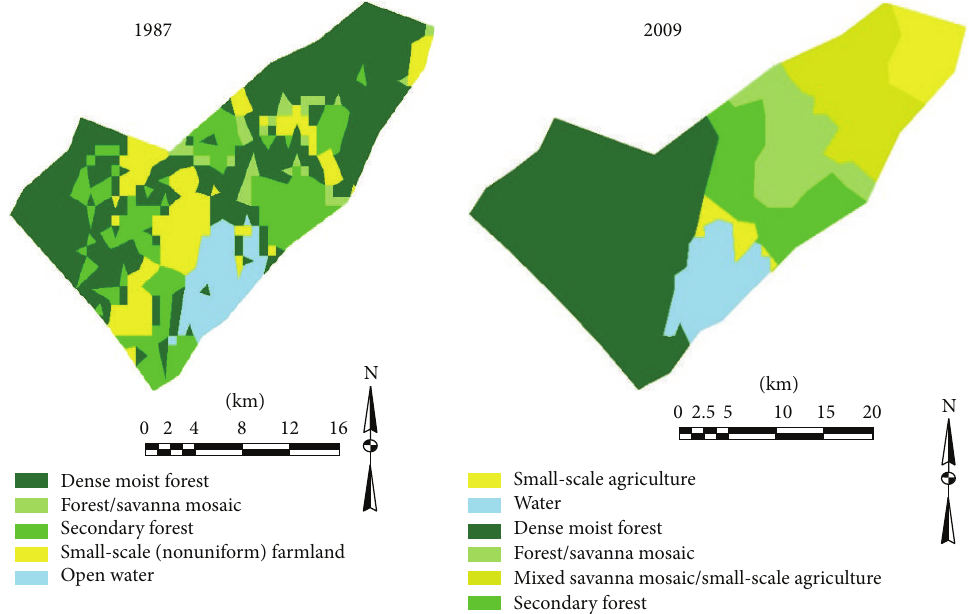
Figure 3: Land-use/cover distribution in Mupfuni Shanga benchmarked site (D.R. Congo).